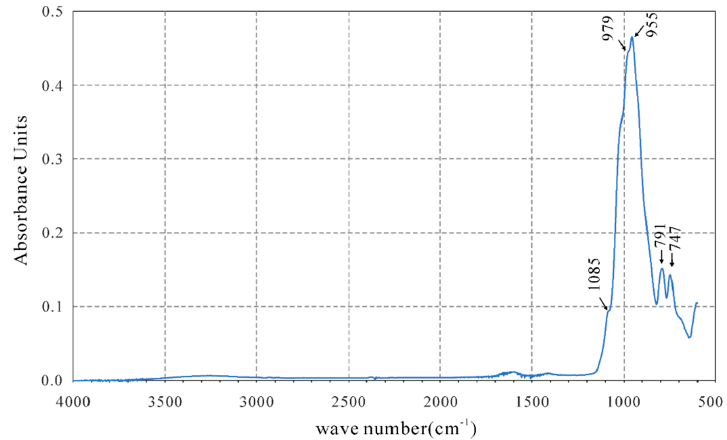
Figure 2. Infrared spectra of fluorluanshiweiite.